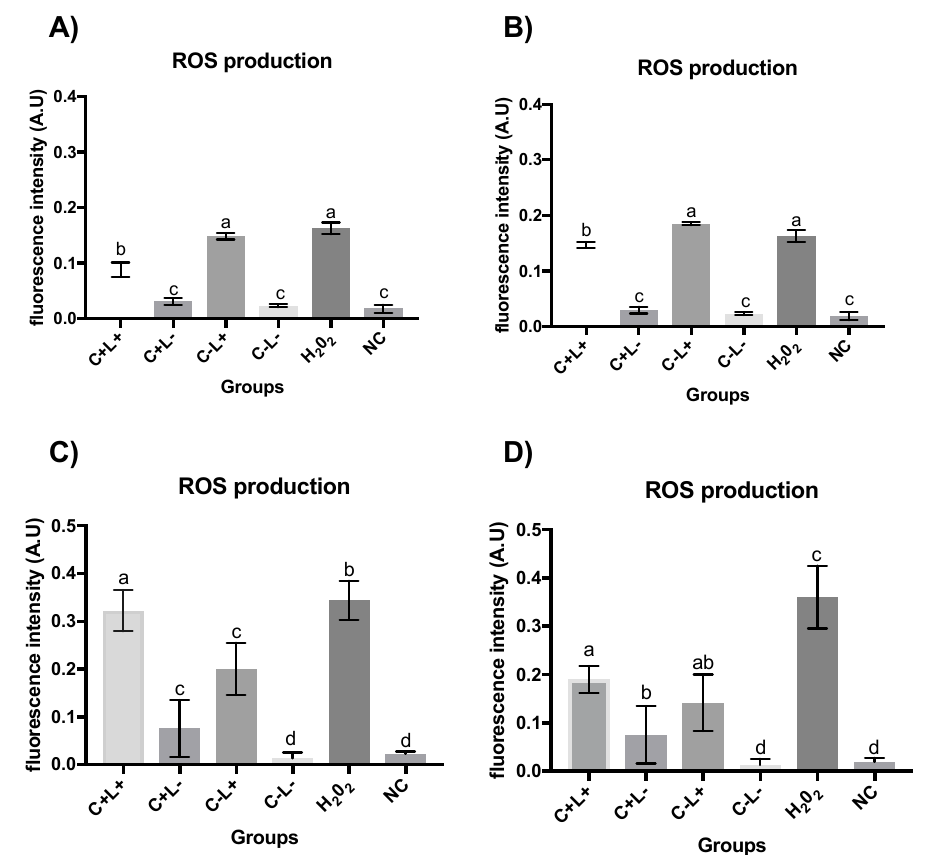
Figure 11. Graphic representation of the mean values and standard deviation of ROS production, measured as fluorescence intensity by fluorometric H2DCF-DA oxidation, of C. albicans suspensions ( A , B ) and biofilm ( C , D ) after the first application ( A , C ), third application ( B ), and tenth application ( D ) subjected to aPDT (C+L+), CUR (C+L − ), light only (C − L+), no treatment (C − L − ), hydrogen peroxide (H 2 O 2 ), and negative control group with cells treated in no fluorochrome (NC). A.U.— arbitrary units. Different letters (a; b; c; d) denote statistical differences between columns (groups) according to the Games–Howell post-test ( p < 0.05) ( n = 12).